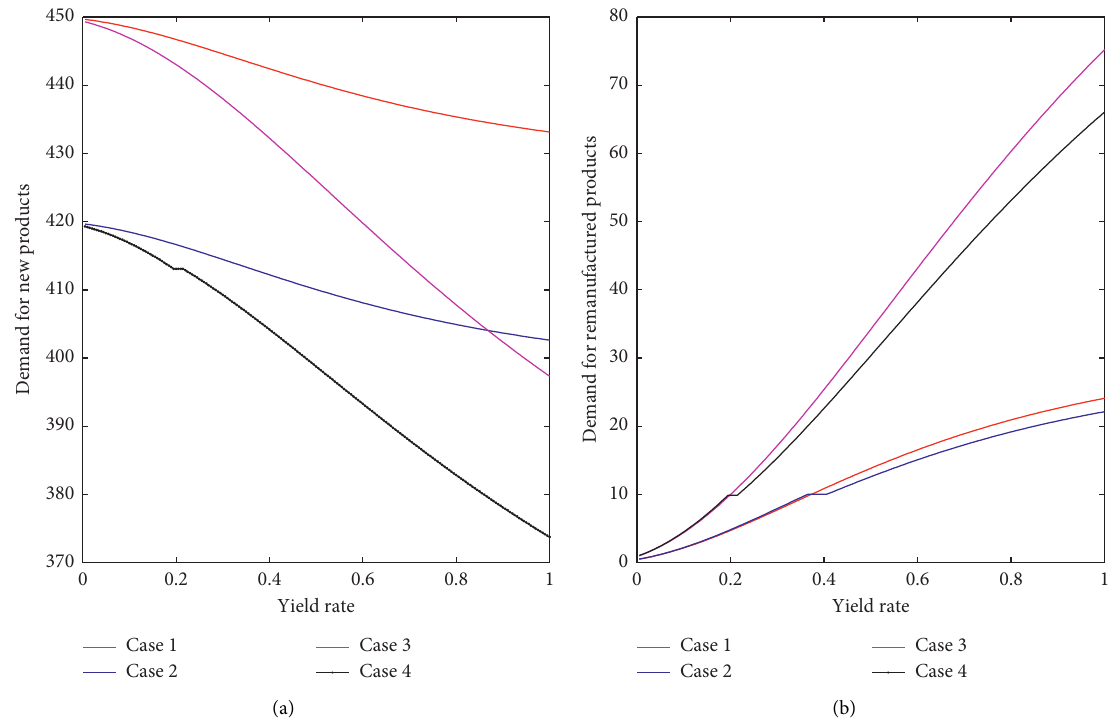
Figure 2: (a) Manufacturing quantity/demand for new products and (b) remanufacturing quantity/demand for remanufactured products vs. yield rate.